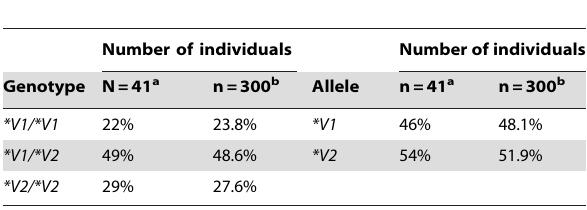
Table 2. Genotypic and allelic frequencies of the VNTR polymorphism in the IDO1